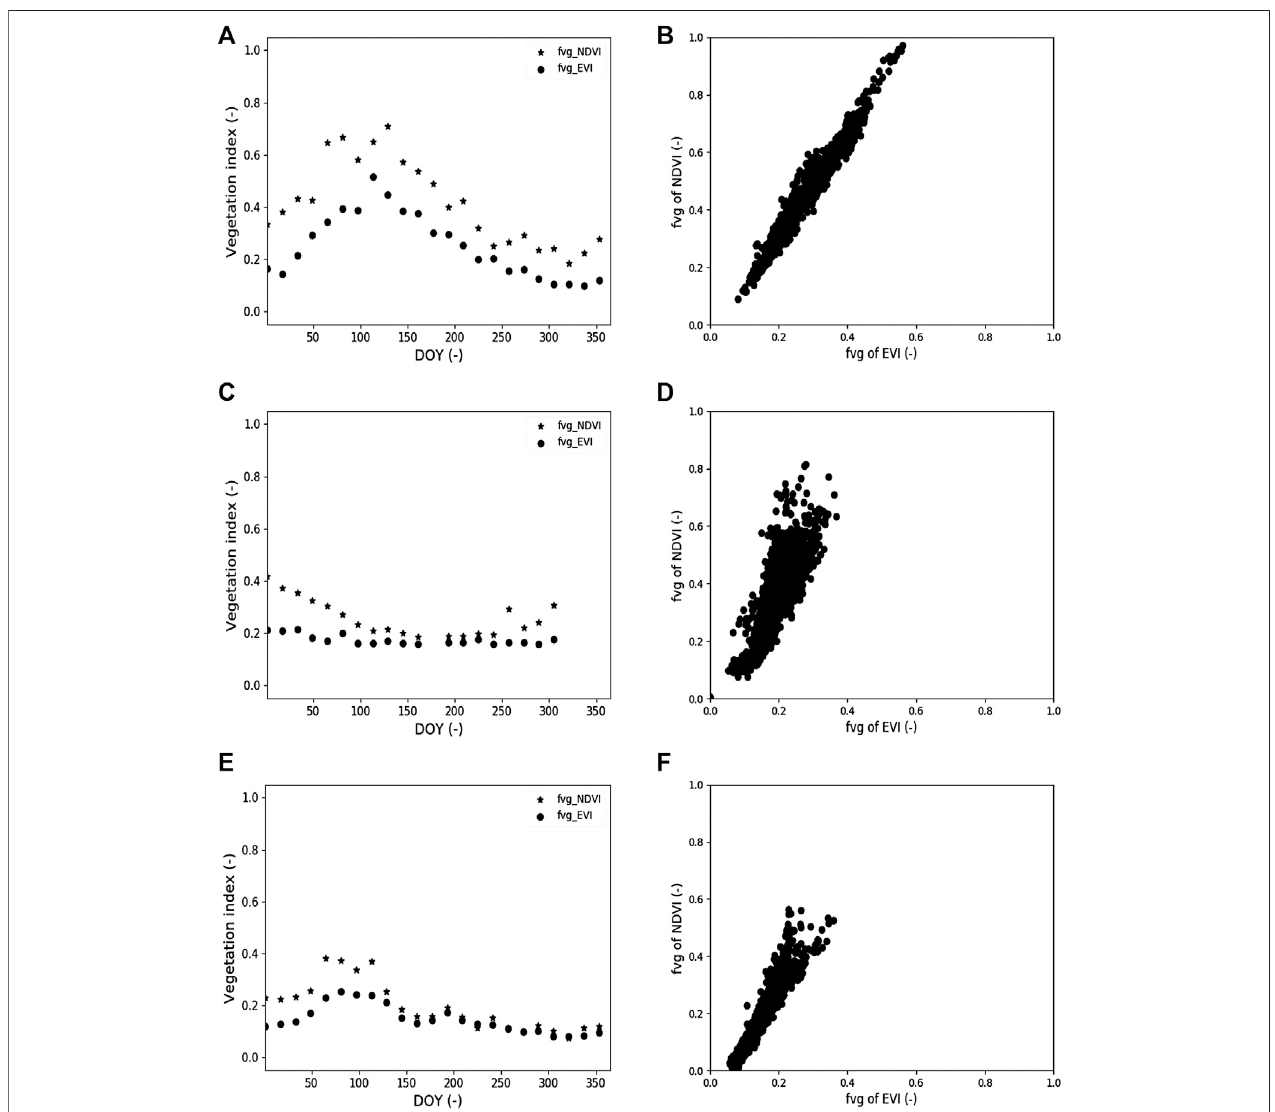
FIGURE 2 | Times series of fractional vegetation cover derived from NDVI and EVI (left) and a spatial scatterplot of fractional vegetation cover derived from NDVI and EVI (right) for Auradé (ICOS) site, 2017 (A,B) ; BA (dryland) site, 2019 (C,D) ; and L03 (REMEDHUS) site, 2017 (E,F) .